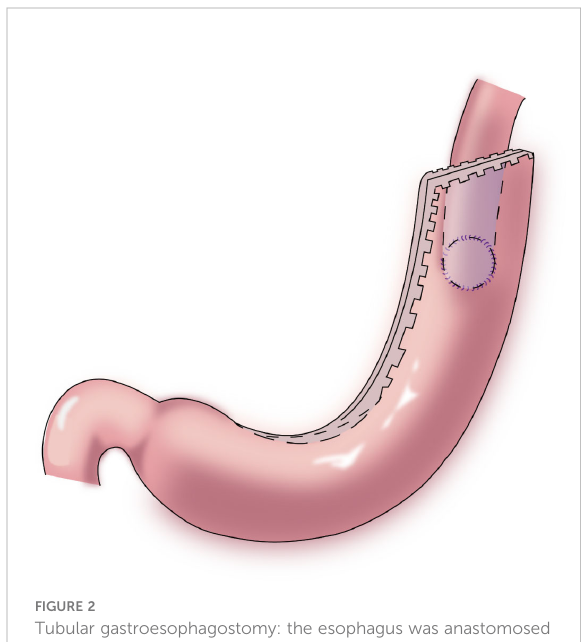
FIGURE 2 Tubular gastroesophagostomy: the esophagus was anastomosed with the posterior wall of the residual stomach using a tubular stapler.